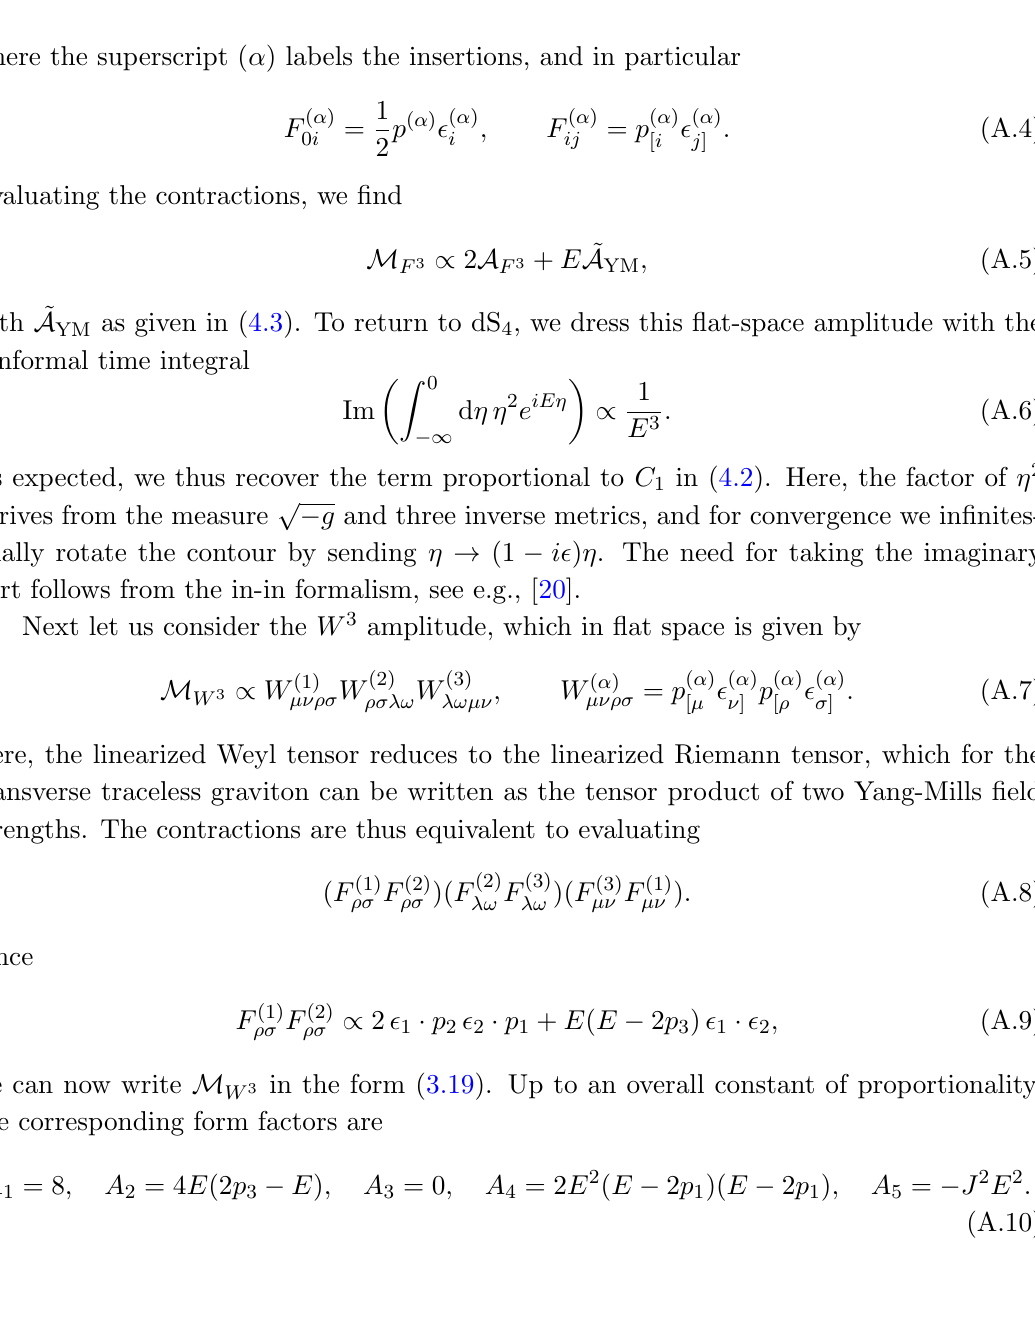
Figure 1 . Tree-level diagrams for 3-point correlators. The (cid:12)rst diagram describes W 3 and F 3 interactions, while the second diagram describes (cid:30)F 2 and (cid:30)W 2